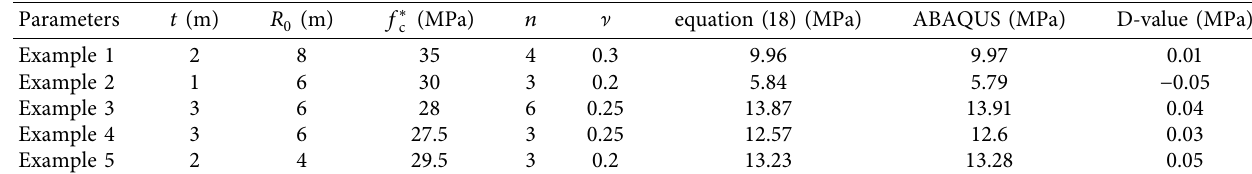
Figure 16: Variations in ultimate bearing capacity and maximum tangential strain with λ . (a) Ultimate bearing capacity. (b) Maximum radial displacement. (c) Maximum radial displacement. Table 2: Calculation results of ultimate bearing capacity of lining under random parameters.